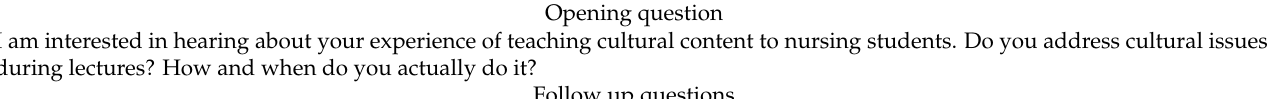
Table 1. Topic guide for the semi-structured